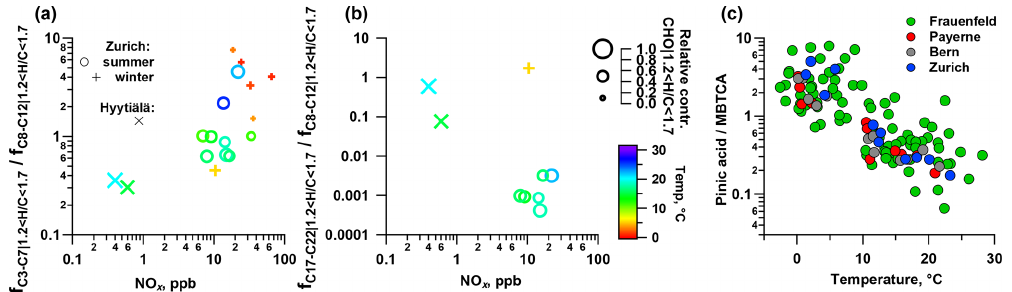
Figure 8. Impact of NO x on the fraction of (a) C3–C7 and (b) C17–C22 relative to C8–C12 compounds and (c) the ratio of pinic acid to MBTCA from LC-MS as a function of temperature.